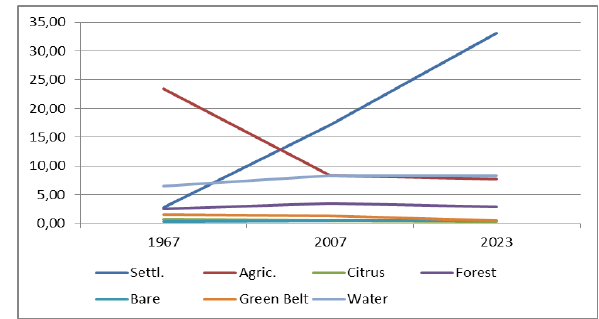
Figure 8. Largest-Patch Index (LPI)